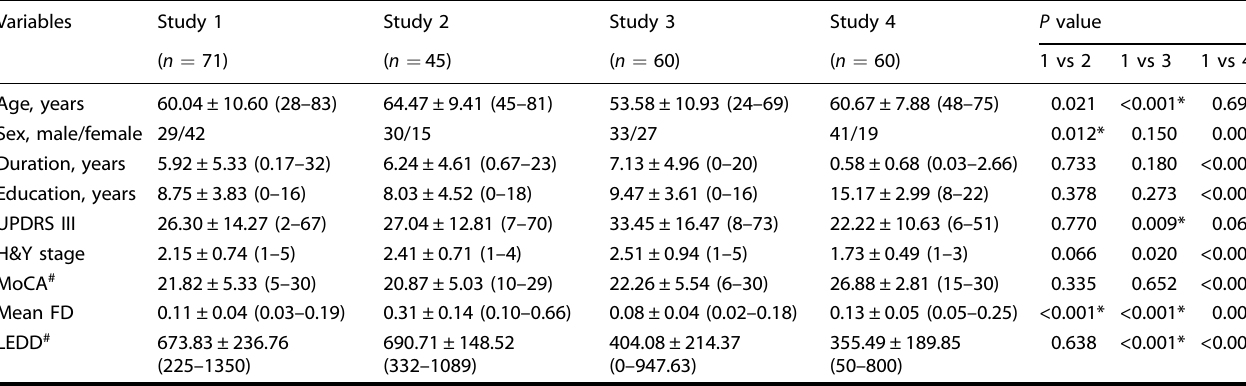
Table 1. Demographic and clinical characteristics of all